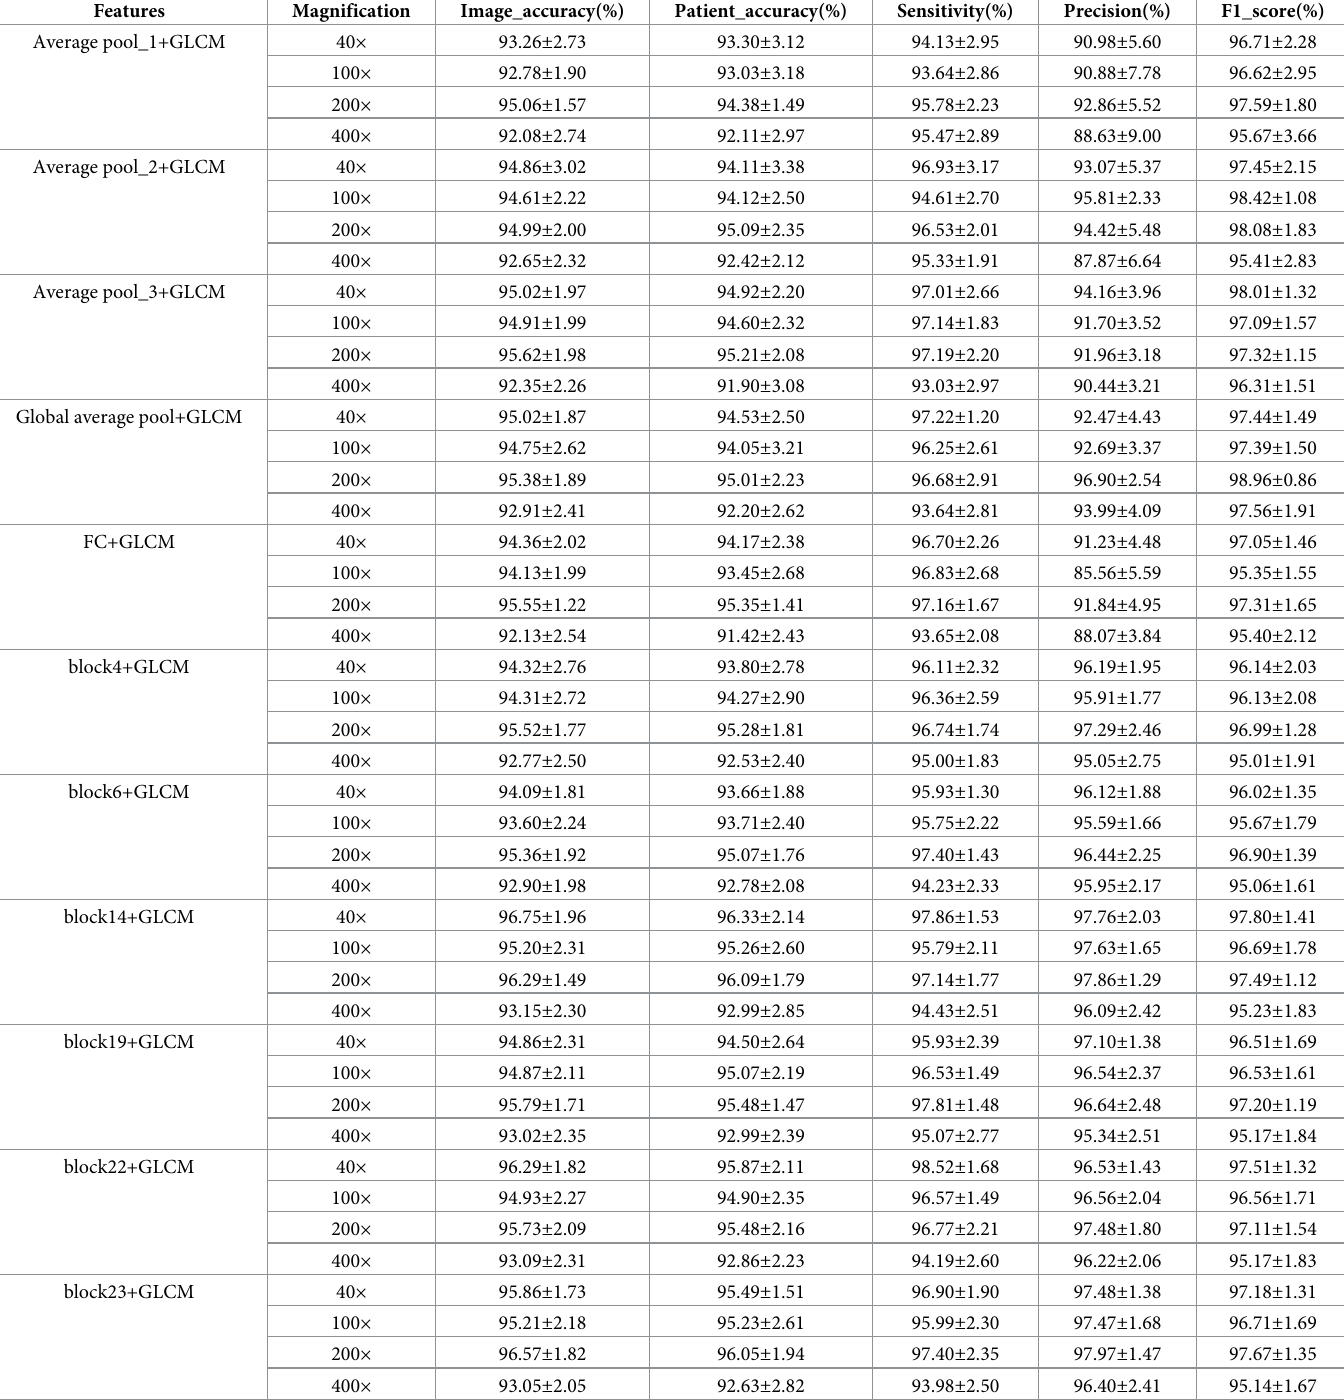
Table 3. MSB classification performance of fused